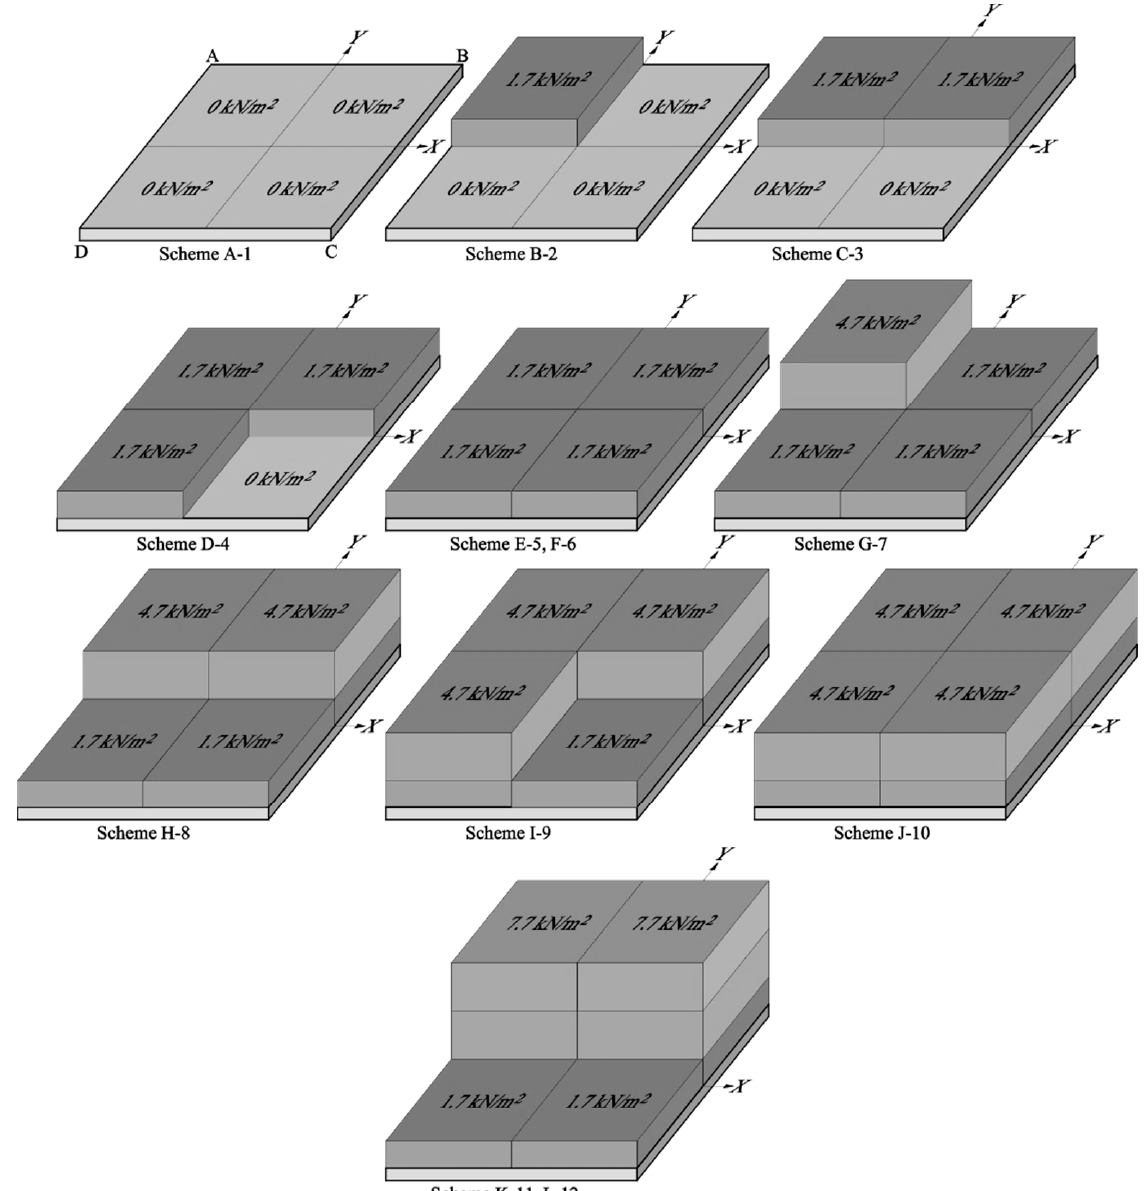
Figure 12. Loading sequences of models. Figure 12.